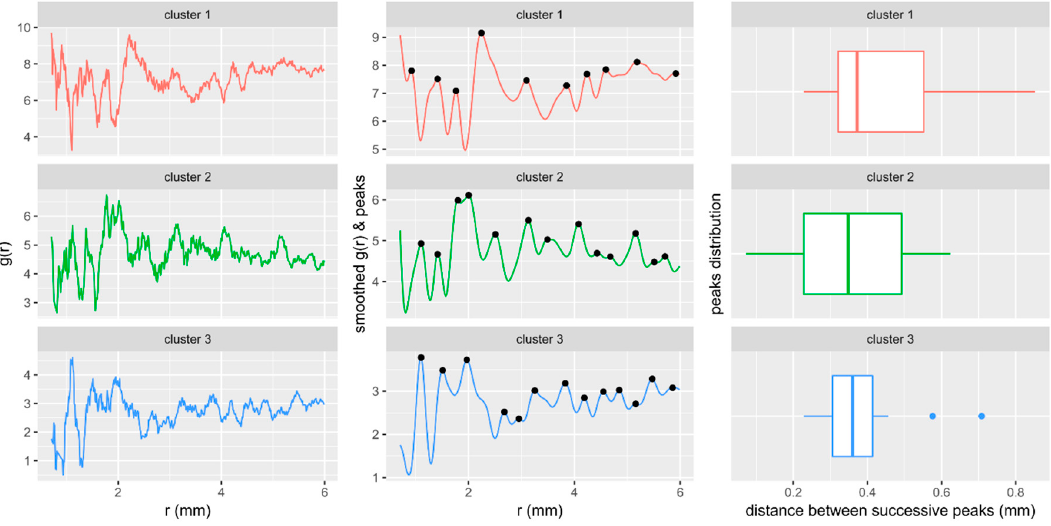
Figure 11. Radial distribution function g(r) calculated for the geometrical centres of grains in the clusters. The grains are well arranged in all clusters and the distribution of their orientation delineates distinct trends, indicating the presence of directional microstructure (Figure 12).